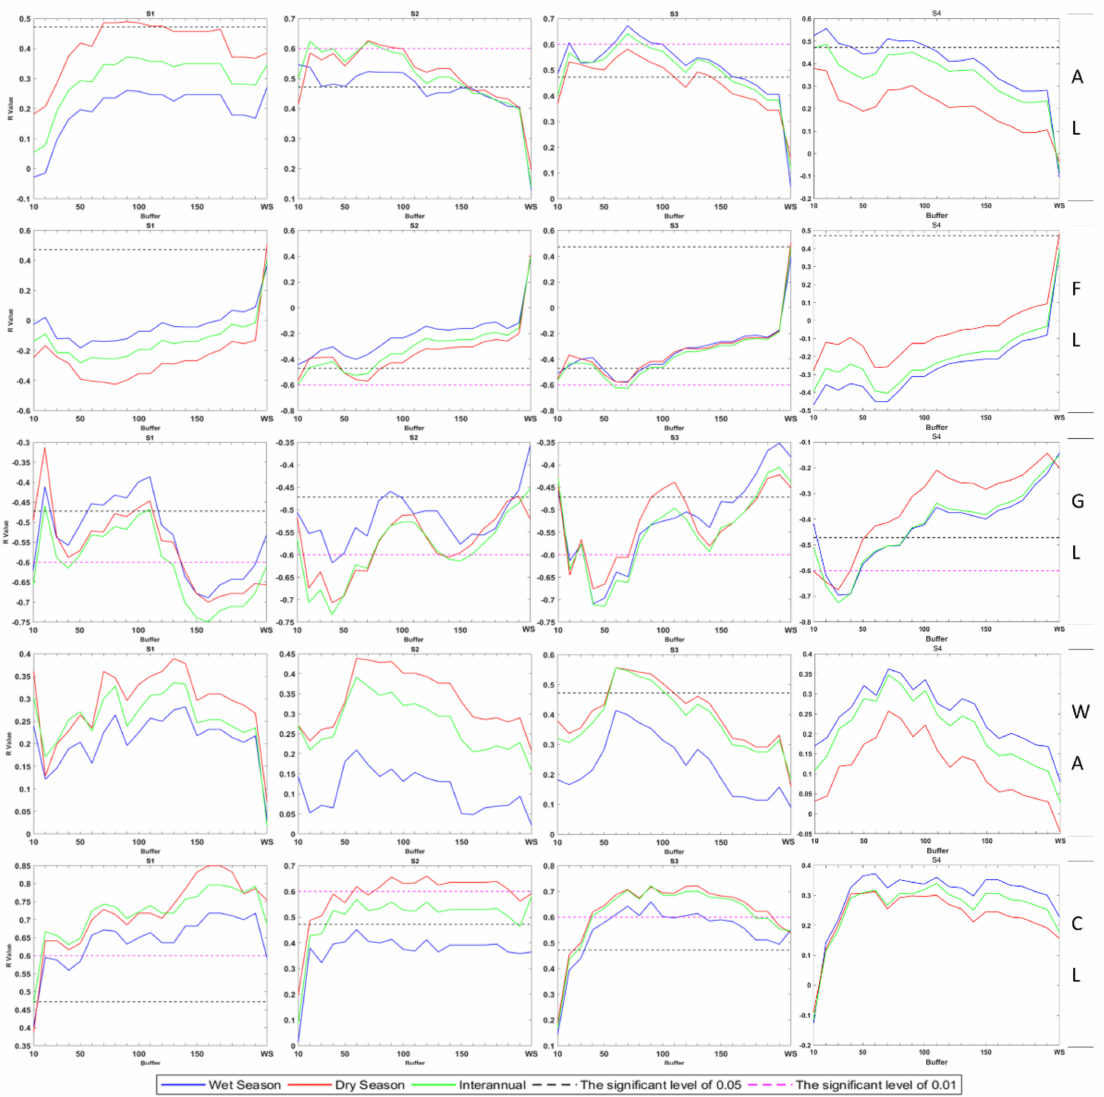
Figure 13. Correlation index of NH 3 -N and different land use types in different seasons in S1, S2, and S3. Each row from the top to the bottom represents a type of land